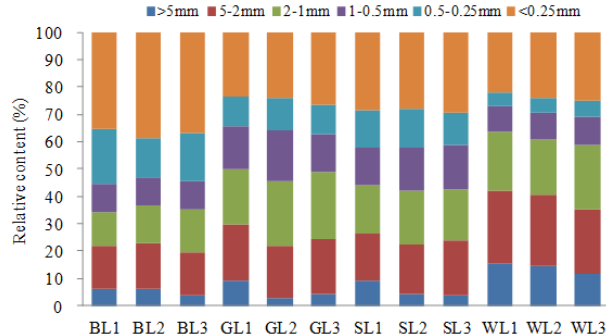
Figure 3. Relative distribution of soil water-stable aggregates with different sizes under different vegetation types (BL1, BL2, BL3, GL1, GL2, GL3, SL1, SL2, SL3, WL1, WL2, and WL3 represent 0–20 (1), 20–40 (2), and 40–60cm (3) soil layers of bare land (BL), grassland (GL), shrubland (SL), and woodland (WL),